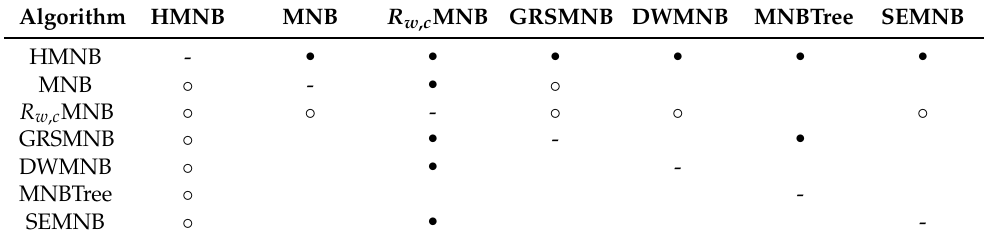
Table 5. Results of the Wilcoxon test with regard to HMNB.